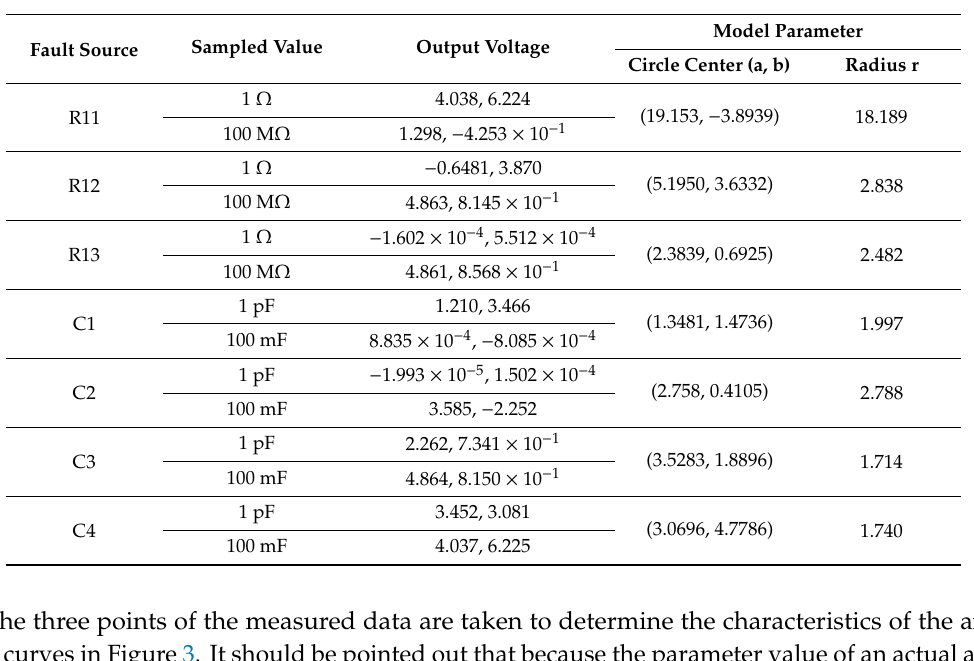
Table 2. Fuzzy groups of the Leapfrog circuit.